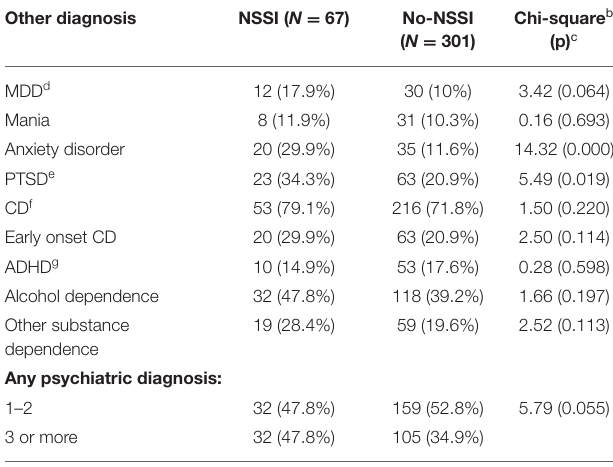
TABLE 1 | Prevalence of lifetime psychiatric diagnoses in delinquent youth with and without NSSI a